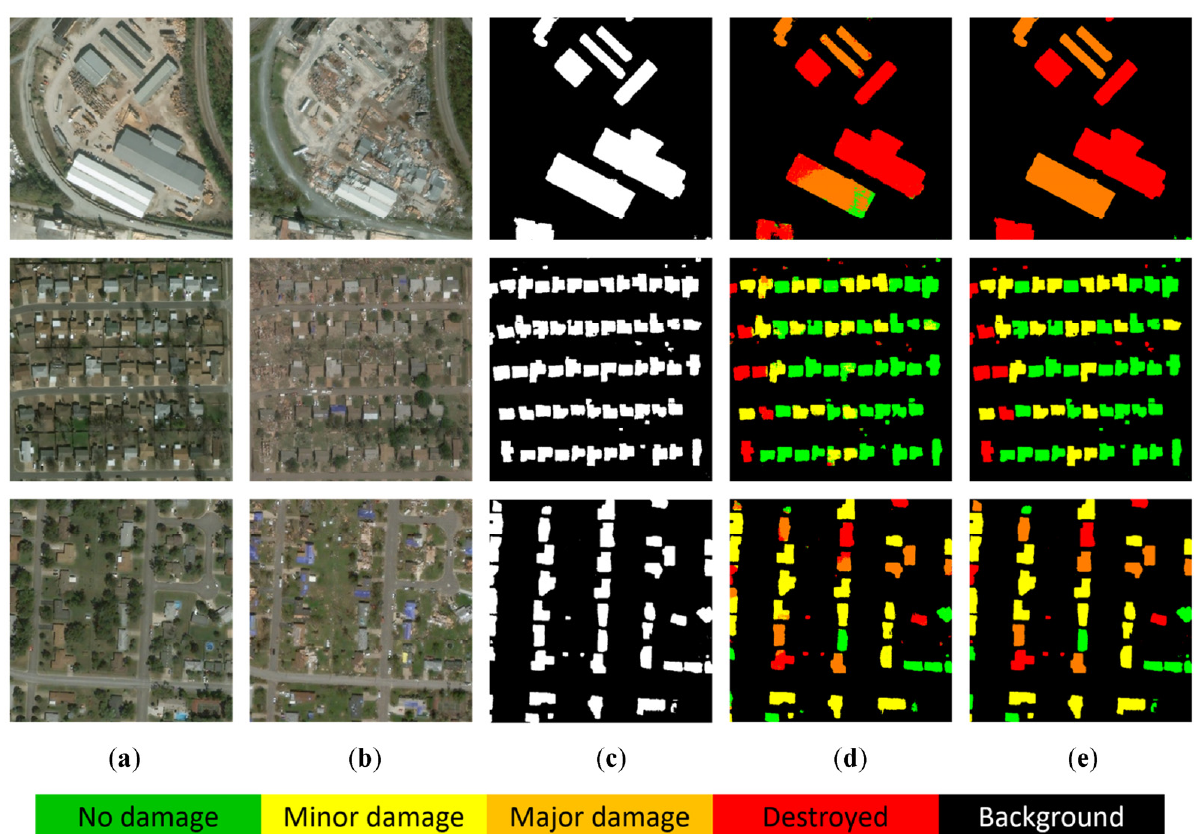
Figure 8. Visual comparison of object-based post-processing results. ( a ) Pre-disaster image, ( b ) post-disaster image, ( c ) building localization results, ( d ) damage classification results, and ( e ) post-processing damage classification results.